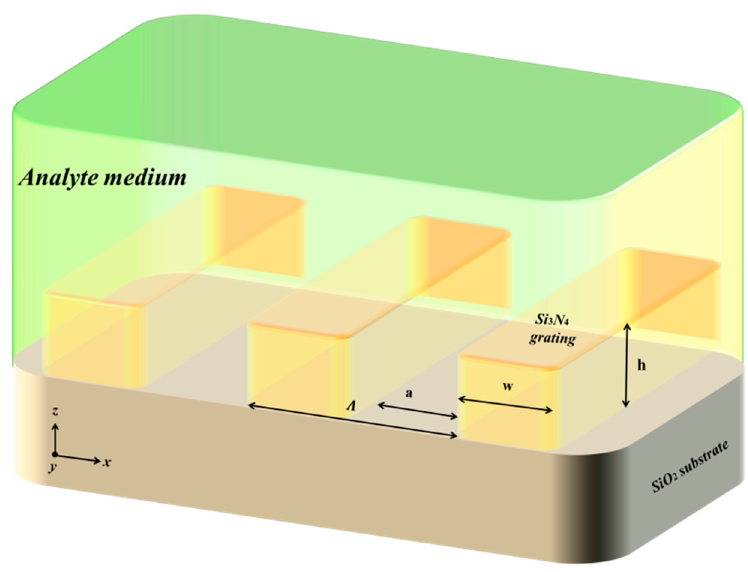
Figure 13. Schematic diagram of the thick SW dielectric grating-based sensor geometry.